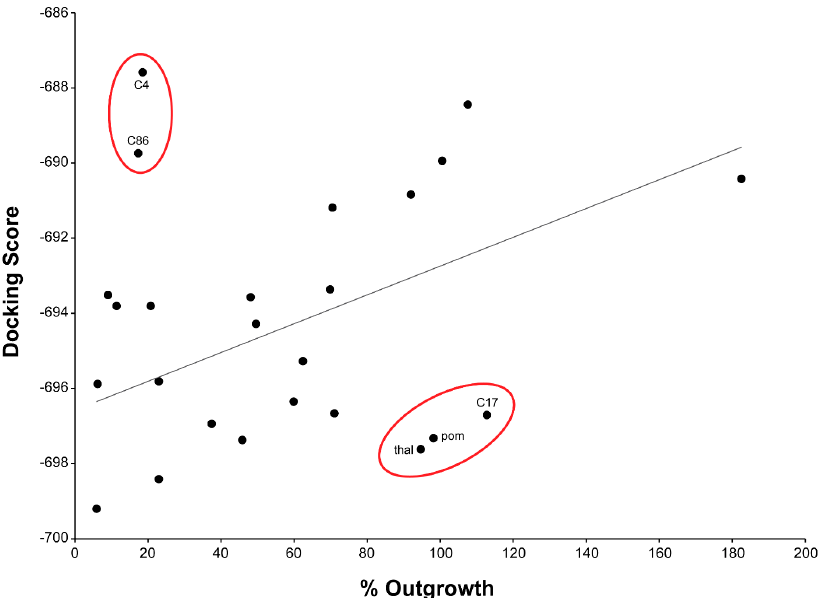
Figure 4. Plot of induced-fit docking score against % outgrowth in the RAR assay. The induced-fit docking score is a function of conformational energy and nonbonded interactions in the receptor–ligand complex. Outliers from the general trend of increased cereblon binding (lower docking score) leading to decreased outgrowth are circled in